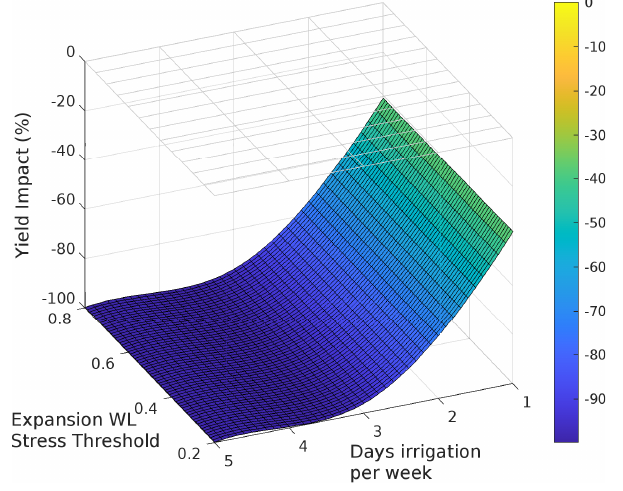
Figure 5. Sensitivity of yield to waterlogging associated with leaf expansion on grain yield.